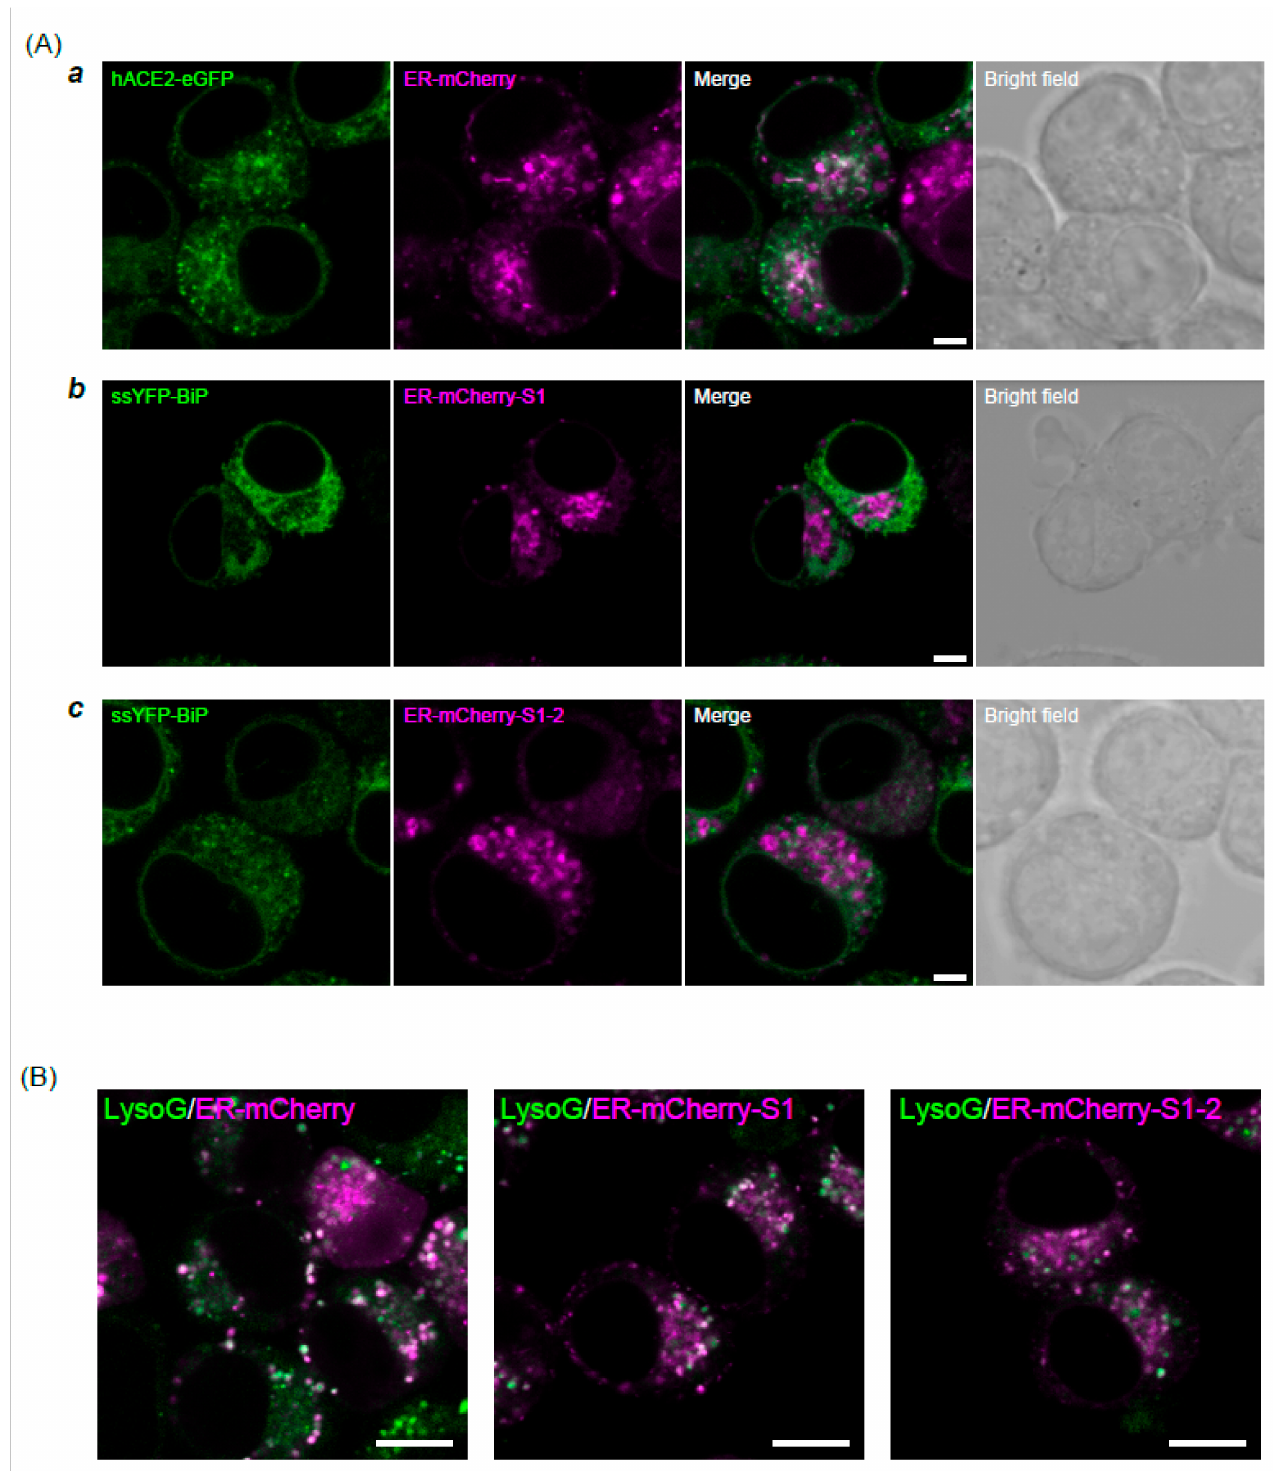
Figure 1. Confocal fluorescent images of murine neuroblastoma Neuro2a cells expressing eGFP-tagged hACE2 and mCherry- tagged S1 proteins. ( A ) Fluorescence images of Neuro2a cells expressing hACE2-eGFP, ER-mCherry-S1, or ER-mCherry-S1-2. Cells co-expressing hACE2-eGFP and ER-mCherry as an ER localization marker, a ; ssYFP-BiP and ER-mCherry-S1, b ; ssYFP-BiP and ER-mCherry-S1-2, c . Bar = 5 µ m. ( B ) Lysotracker Green-stained Neuro2a cells expressing ER-mCherry as control, ER-mCherry-S1, and ER-mCherry-S1-2. Bar = 10 µ